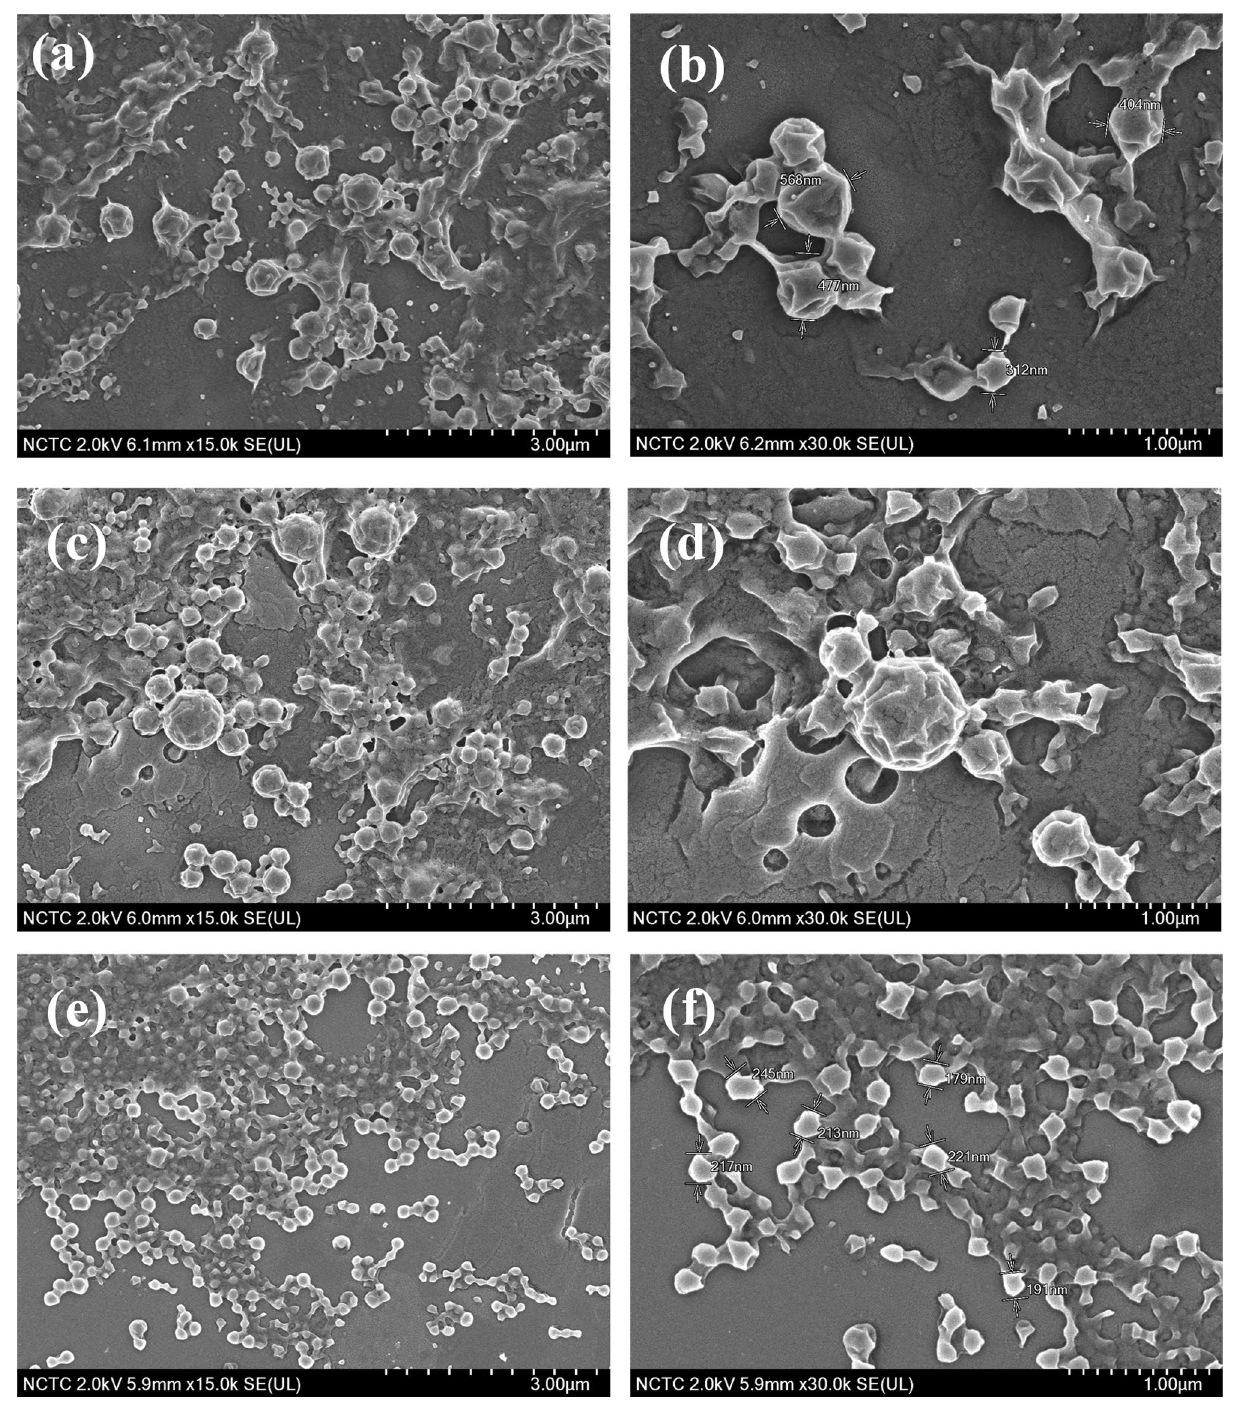
Figure 10. SEM images of alcohol-acidolyzed PLA particles obtained from different emulsion preparation conditions: ( a , b ) LD12M(2%)-SDS(0.1%), ( c , d ) LD12M(2%)-SDS(0.1%)-NaOH(0.001 M), and ( e , f ) LD12M(2%)-SDS(0.1%)-HCl(0.001